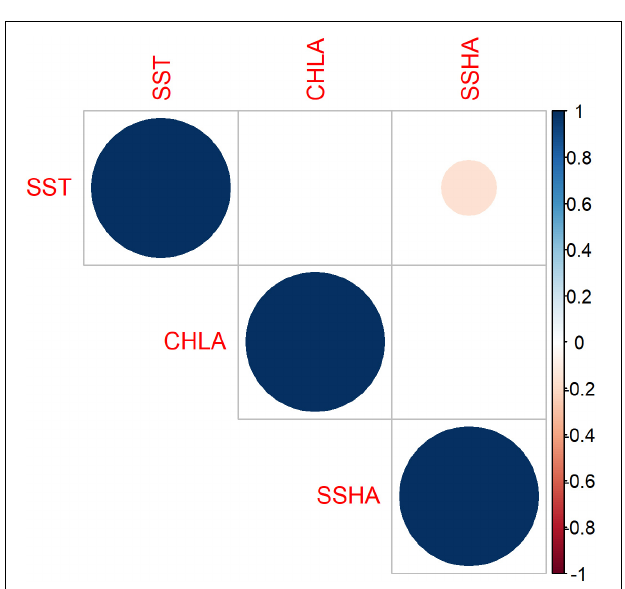
FIGURE 4 | Cross-correlation plot of sea surface temperature (SST), sea surface height anomaly (SSHA), and chlorophyll-a concentration (CHLA) showing significant relationships ( α = 0.05). Size of dots indicates strength of correlation and blanks where no correlation was